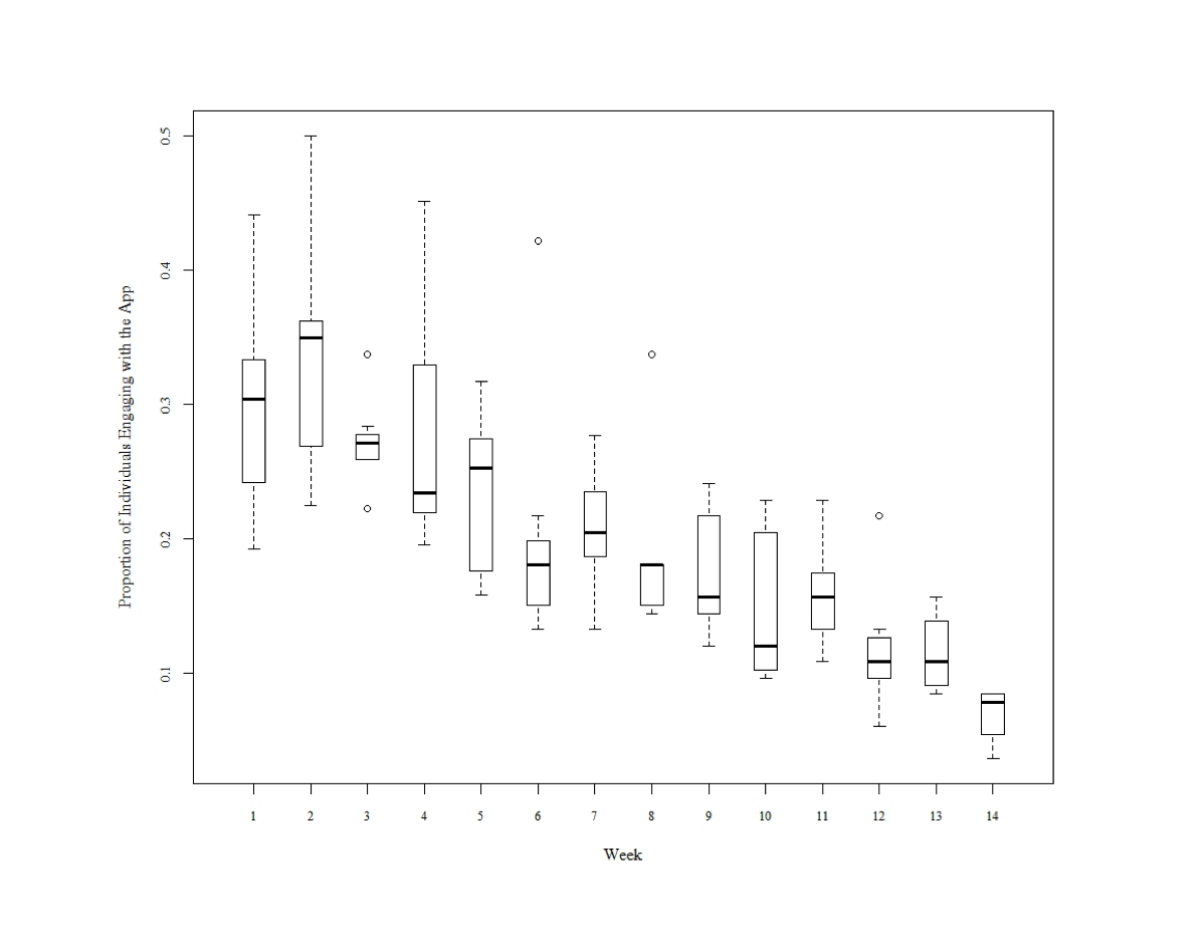
Figure 3. Cogito Companion app engagement. Note: Active app use data is incomplete for the first 7 participants. All available data is